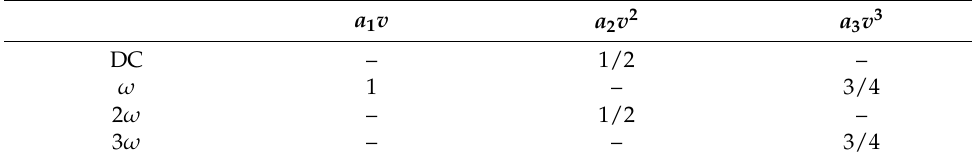
Table 5. Nonlinear coefficients of harmonic components.